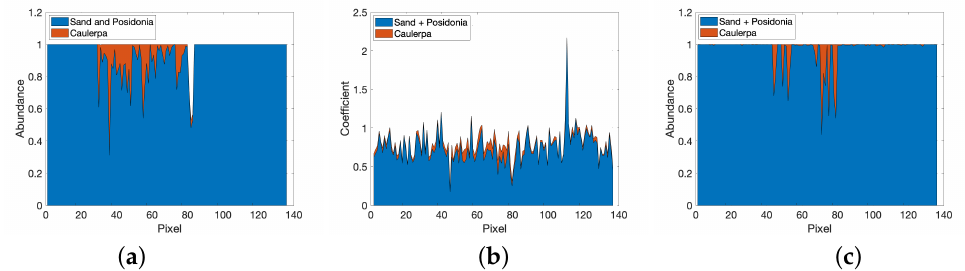
Figure 8. Part 2; ( a ) Abundances provided by the ground truth ( A GT ); ( b ) LS coefficients ( C est ); ( c ) Abundances obtained using WADJUM ( A est